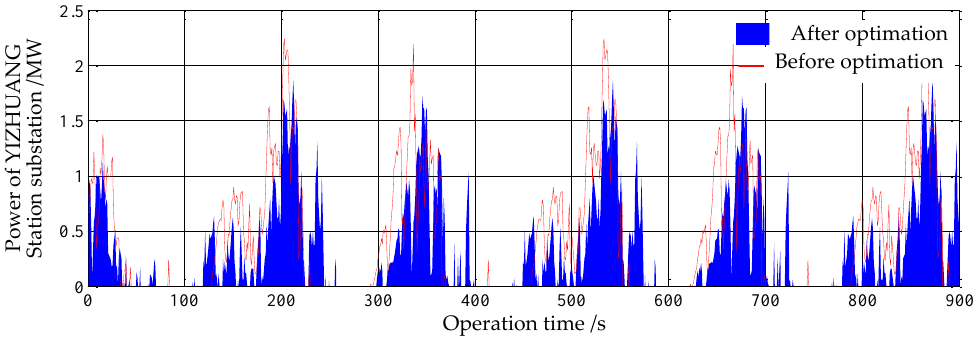
Figure 17. Energy consumption of each substation before and after dwell time optimization.